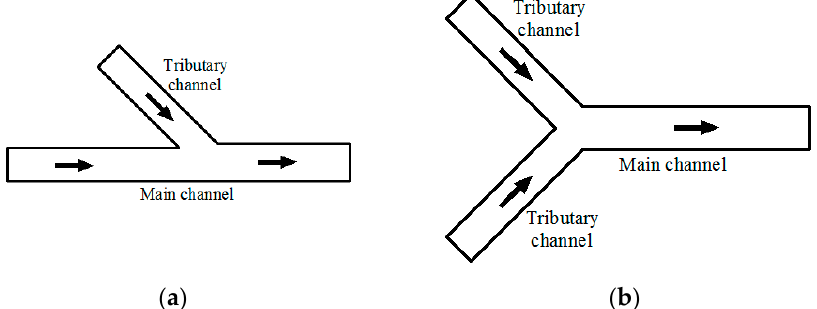
Figure 1. Two types of confluence channels: ( a ) Asymmetrical confluences; ( b ) Y-shaped confluences.